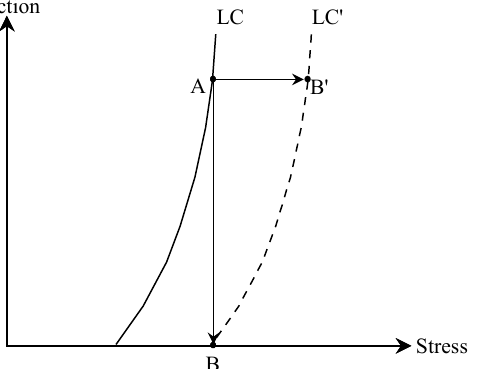
Table 2. Parameters for GMZ bentonite. Figure 11. The collapse strain induced by the suction-decrease path. AB: suction reduction path, AB (cid:48) : Figure 11. The collapse strain induced by the suction ‐ decrease path. AB: suction reduction path, loading path. AB’: loading path.